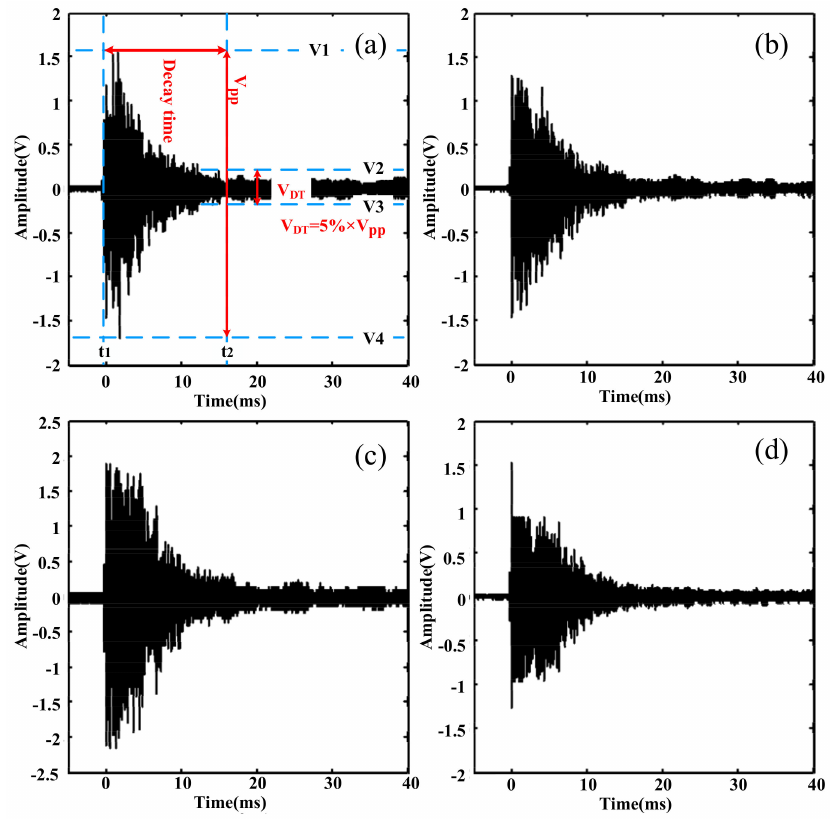
Figure 13. The time domain waveform of the detected PD signals with ( a ) 10-lap fiber probe, ( b ) 40-lap fiber probe, ( c ) 70-lap fiber probe and ( d ) 100-lap fiber probe.